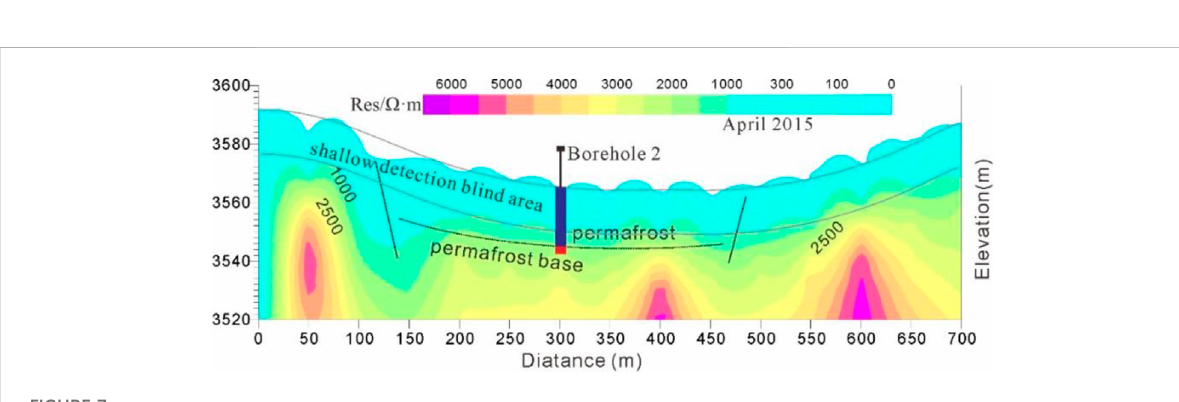
FIGURE 7 Nano-TEM sounding pro fi le 2 of Mahan Mountain, April